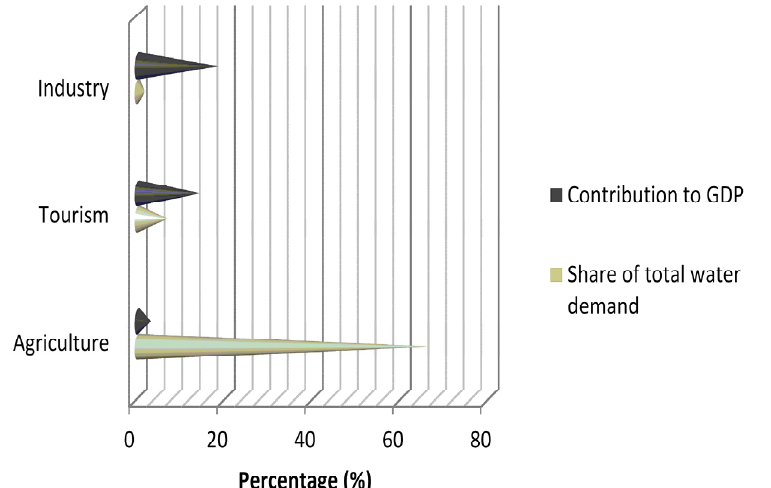
Figure 7. Demand share by sector and contribution to GDP for the year 2006 (Data: WDD statistics [32] and Cystat, 2009